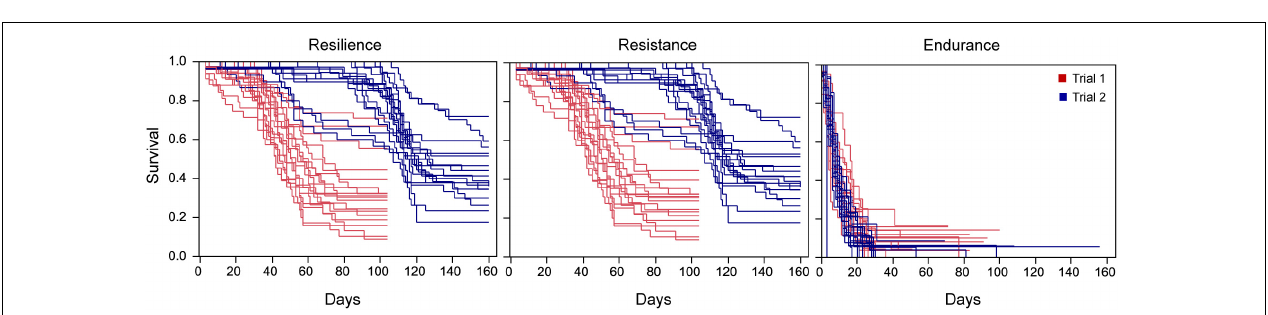
FIGURE 1 | Number of uncensored (light) and censored (dark) data in successive 10-day periods for resilience, resistance, and endurance, and both trials.